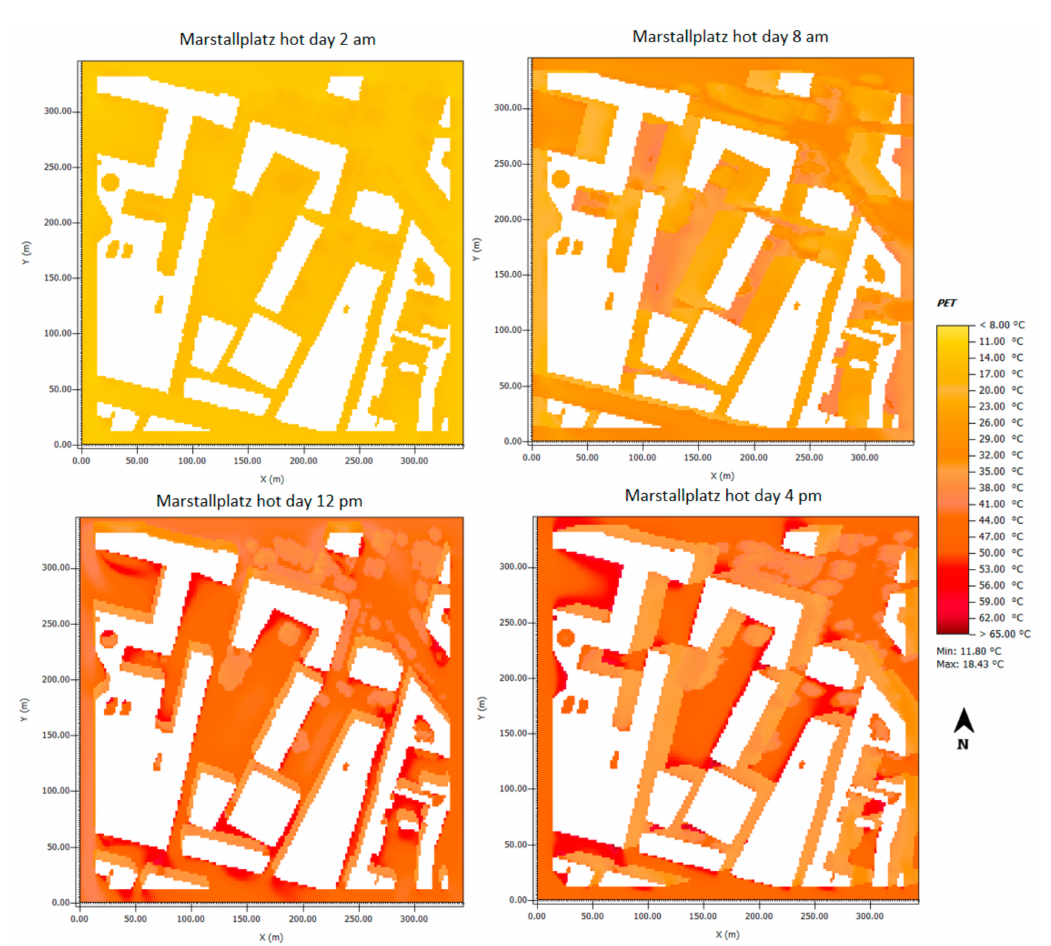
Figure 9. Marstallplatz’s PET variation during the hot day (2 am, 8 am, 12 pm, 4